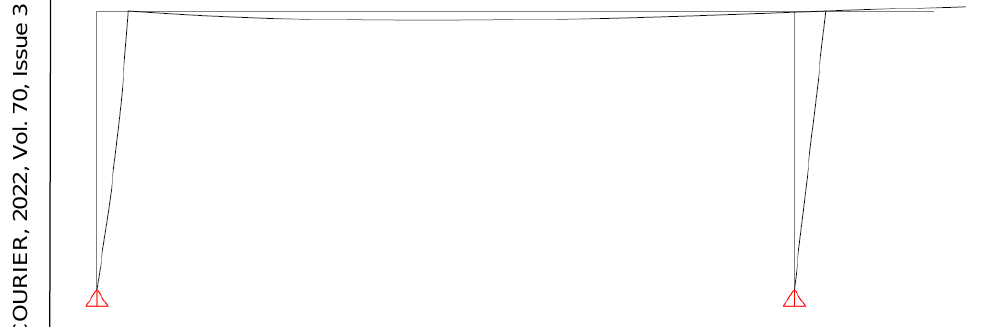
Figure 9 – 1 st mode shape of the crane carrying structure Рис. 9 – 1 формa колебаний несущей конструкции крана Слика 9 – Први облик осциловања носеће конструкције дизалице